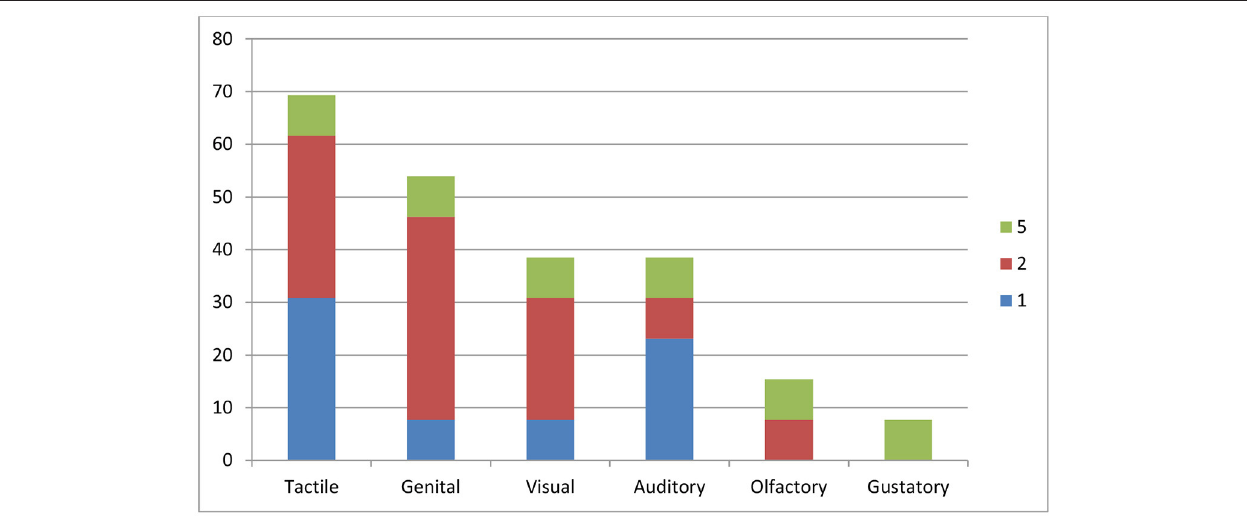
FIGURE 1 | Percentage of patients experiencing s exual hallucinations, per sensory modality. The x axis indicates the sensory modality involved; the y axis the percentage of participants ( n = 30) experiencing hallucinations in that particular sensory modality. Color codings indicate the presence of multimodal hallucinations (in up to five sensory modalities). As some of the participants experienced hallucinations in more than one sensory modality, the total percentage is higher than